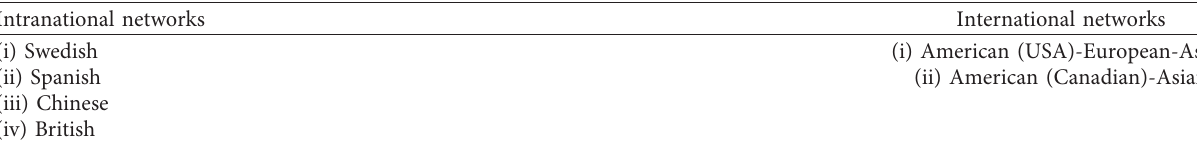
Table 6: Main intranational and international scientific